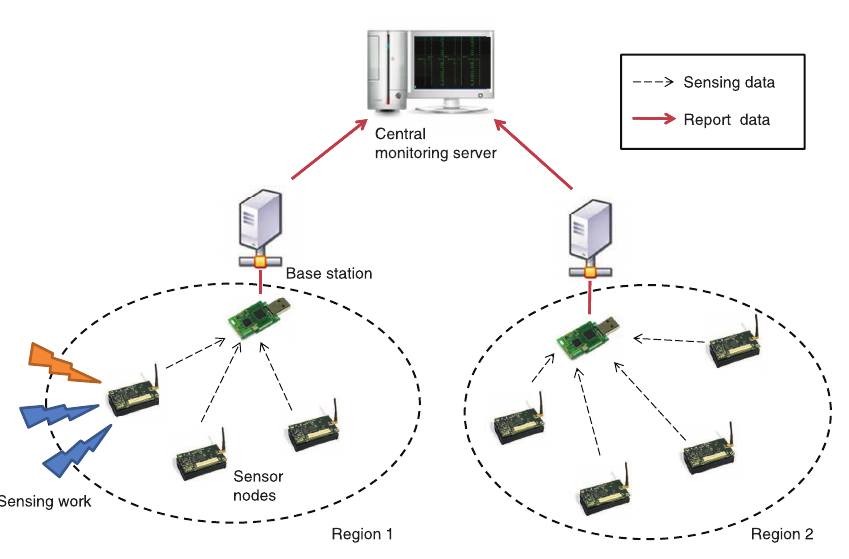
Figure 2. The system model of the networked sensor platform.